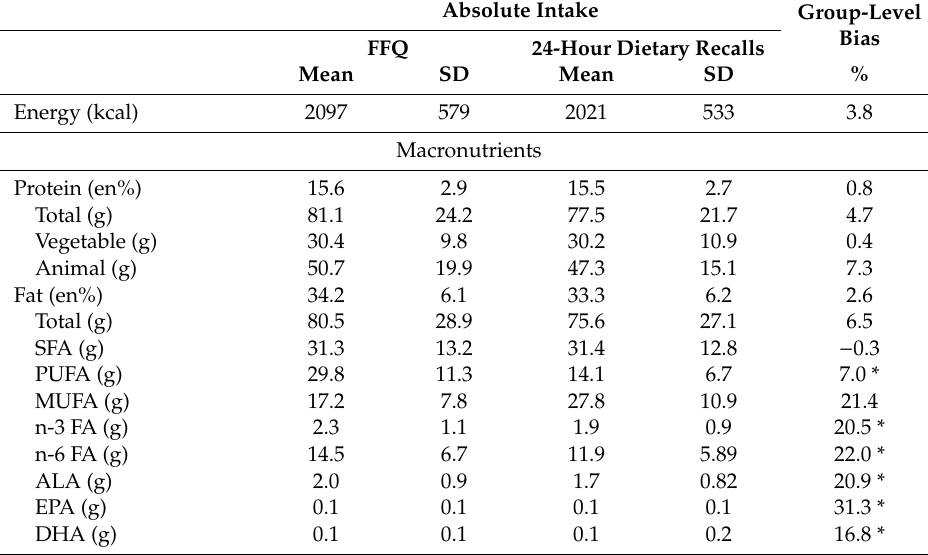
Table 2. Mean energy, nutrient, and food group intake from the food frequency questionnaire and three 24-hour dietary recalls and group level bias between the two methods in the 88 validation study participants of the Longitudinal Aging Study